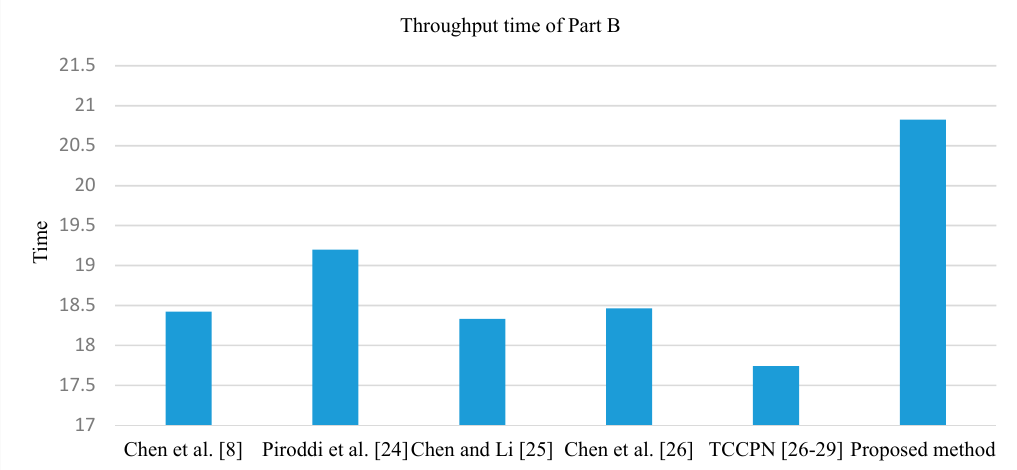
Figure 16. Comparison of throughput time of Part B for the Petri net model from Figure 11.